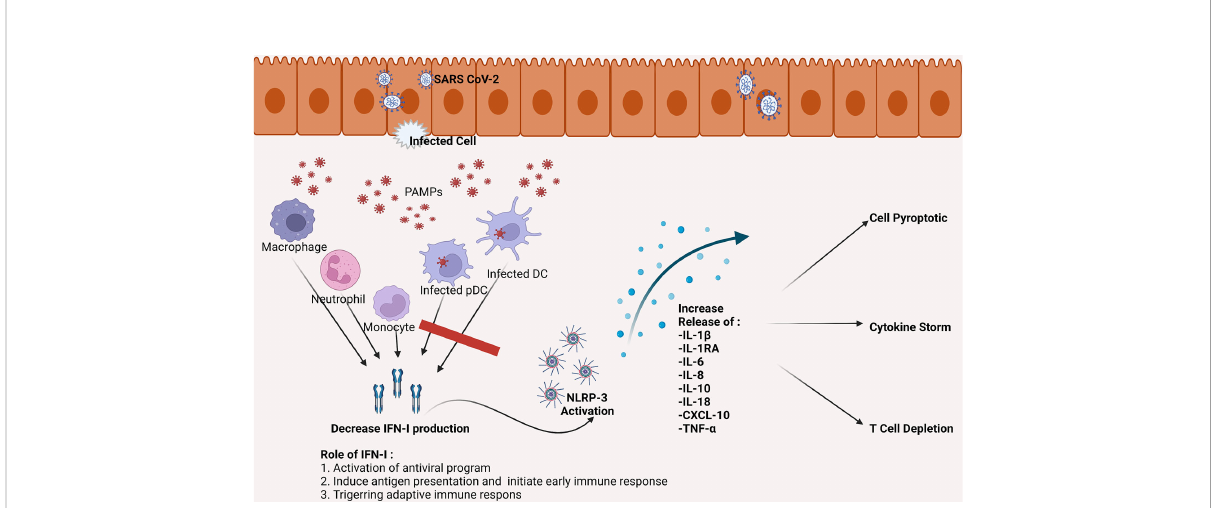
FIGURE 1 SARS-CoV-2 can infect DC, including pDC, which is the primary producer of IFN-I. The SARS-CoV-2 infection causes a decrease in the number of DC as well as a decrease in IFN-I production. Inadequate IFN-I leads to failed elimination of SARS-CoV-2. The failure eventually increased the activity of NLRP-3, which leads to pro-in fl ammatory cytokines increase which then triggers cell apoptotic, cytokine storms, and depletion of T cells. CXCL, the chemokine C-X-C motif ligand; DC, dendritic cell; IFN, interferon; IL, interleukin; NLRP-3, NLR family pyrin domain containing 3 in fl ammasome; pDC, plasmacytoid dendritic cell; TNF, tumor necrosis